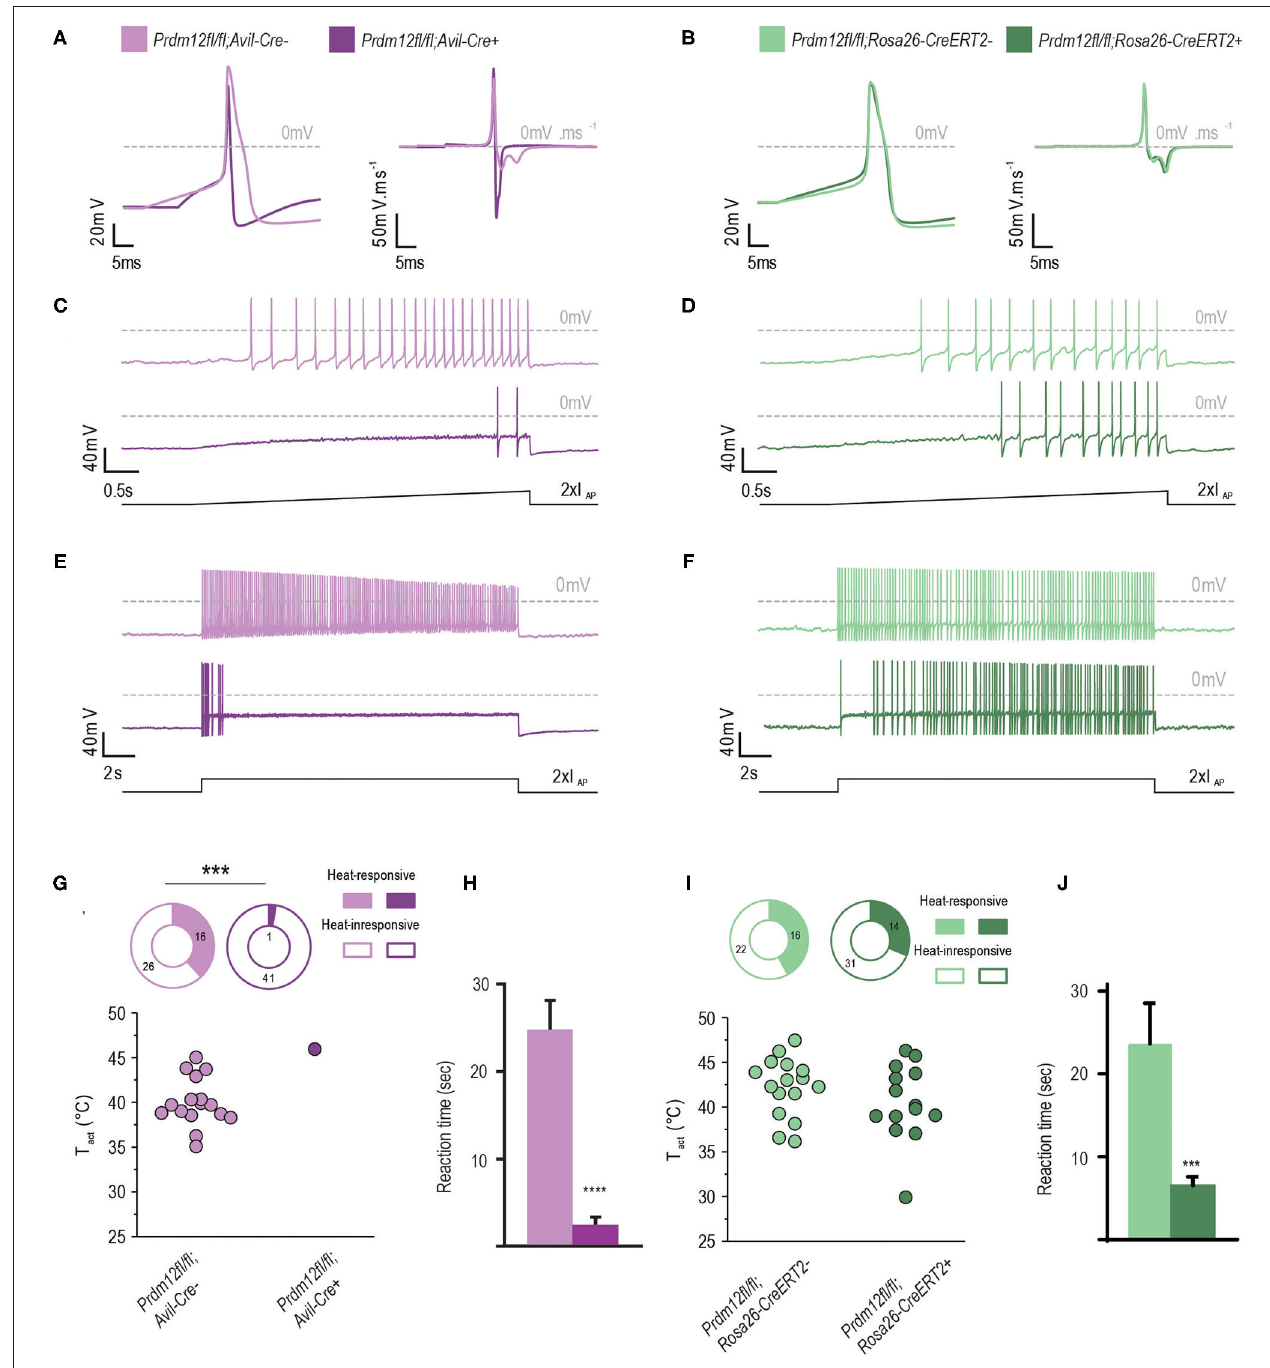
FIGURE 4 | PRDM12 expression is required for proper biophysical properties of cultured DRG. (A) and (B) Representative action potentials (APs) and their first derivatives from Prdm12 fl / fl ; Avil-Cre + [ (A) , dark purple trace], Prdm12 fl / fl ; Avil-Cre − [ (A) , light purple trace], Prdm12 fl / fl ; Rosa26-CreER T 2 + [ (B) , dark green trace], and Prdm12 fl / fl ; Rosa26-CreER T 2 − [ (B) , light green trace] cultured DRG neurons. Note the reduced AP width and lack of biphasic repolarization in Prdm12 fl / fl ; Avil-Cre + (A) . (C,D) Typical examples of AP generation upon 2 x I AP ramp-shaped depolarization showing the inability of Prdm12 fl / fl ; Avil-Cre + DRG neurons to generate similar number of APs compared to the Prdm12 fl / fl ; Avil-Cre − DRG neurons (C) . Note the delay of AP firing for initial 2s in the ramp-shaped depolarization in Prdm12 fl / fl ; Avil-CreER T 2 + , as compared to littermate controls (D) . (E) Prdm12 fl / fl ; Avil-Cre + neurons dot not generate APs over the full time course of 2 x I AP current injection compared to Prdm12 fl / fl ; Avil-Cre − neurons. (F) The TAM-injected Prdm12 fl / fl ; Rosa26-CreER T 2 + and Prdm12 fl / fl ; Rosa26-CreER T 2 − generate APs over the full length of 2 x I AP current injection although the TAM-injected Prdm12 fl / fl ; Rosa26-CreER T 2 + show a reduced number of APs in the beginning of the 2 x I AP current injection. (G,I) Fraction of neurons that showed temperature-evoked currents (top panels) and temperature activation thresholds ( T act ) of the recorded neurons (bottom panels). Prdm12 fl / fl ; Avil-Cre + neurons do not respond to the applied ramp-shaped temperature increase (G) , whereas in both fractions of TAM-injected Prdm12 fl / fl ;